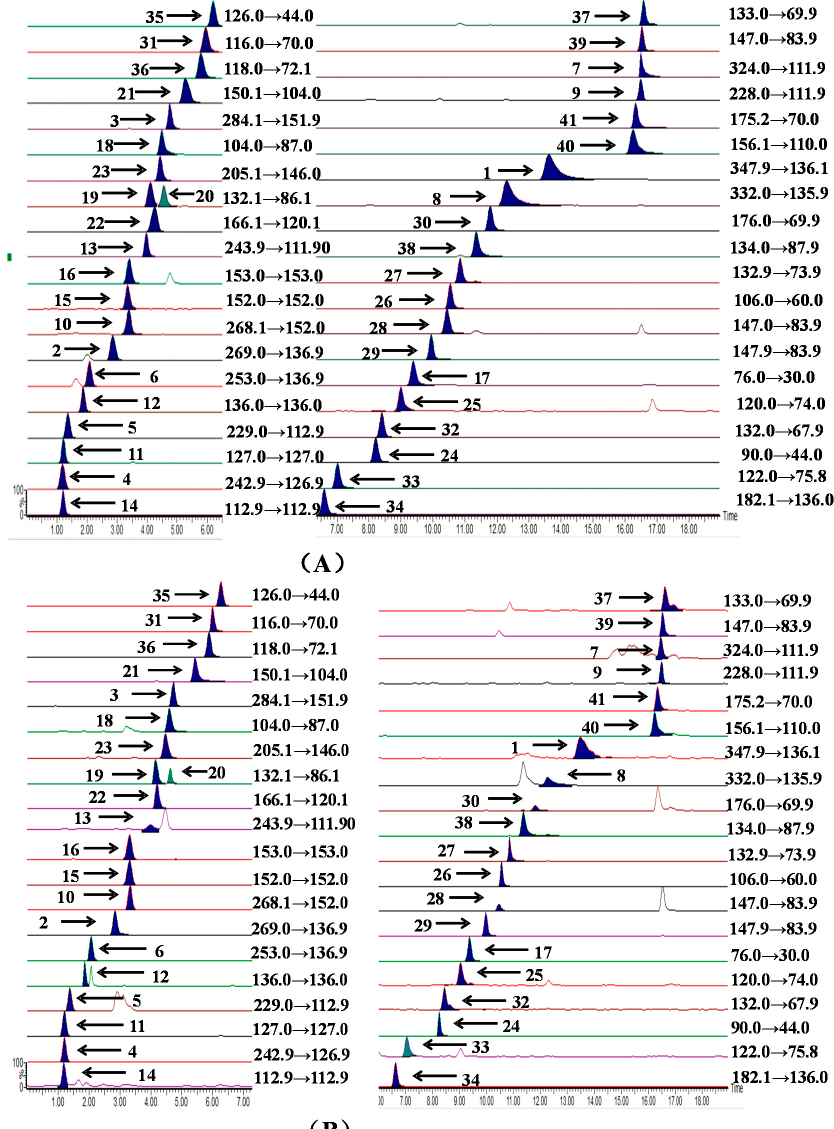
Figure 1. UHPLC–TQ-MS/MS multiple-reaction monitoring (MRM) chromatograms of the mixed standards ( A ) and Sample F1 ( B ). The compound numbers on the chromatograms were adenosine-5 ′ -monophosphate ( 1 ), inosine ( 2 ), guanosine ( 3 ), thymidine ( 4 ), 2 ′ -deoxyuridine ( 5 ), 2 ′ -deoxyinosine ( 6 ), cytidine-5 ′ -monophosphate ( 7 ), 2 ′ -deoxyadenosine-5 ′ -monophosphate ( 8 ), 2 ′ -deoxycytidine ( 9 ), 2 ′ -deoxyguanosine ( 10 ), thymine ( 11 ), adenine ( 12 ), cytidine ( 13 ), uracil ( 14 ), guanine ( 15 ), xanthine ( 16 ), glycine ( 17 ), GABA ( 18 ), leucine ( 19 ), isoleucine ( 20 ), methionine ( 21 ), phenylalanine ( 22 ), tryptophan ( 23 ), alanine ( 24 ), threonine ( 25 ), serine ( 26 ), asparagine ( 27 ), glutamine ( 28 ), glutamate ( 29 ), citrulline ( 30 ), proline ( 31 ), hydroxyproline ( 32 ), cysteine ( 33 ), tyrosine ( 34 ), taurine ( 35 ), valine ( 36 ), ornithine ( 37 ), aspartate ( 38 ), lysine ( 39 ), histidine ( 40 ) and arginine ( 41 ), respectively. The peaks of guanine ( 15 ) and xanthine ( 16 ) were overlapped or embedded.